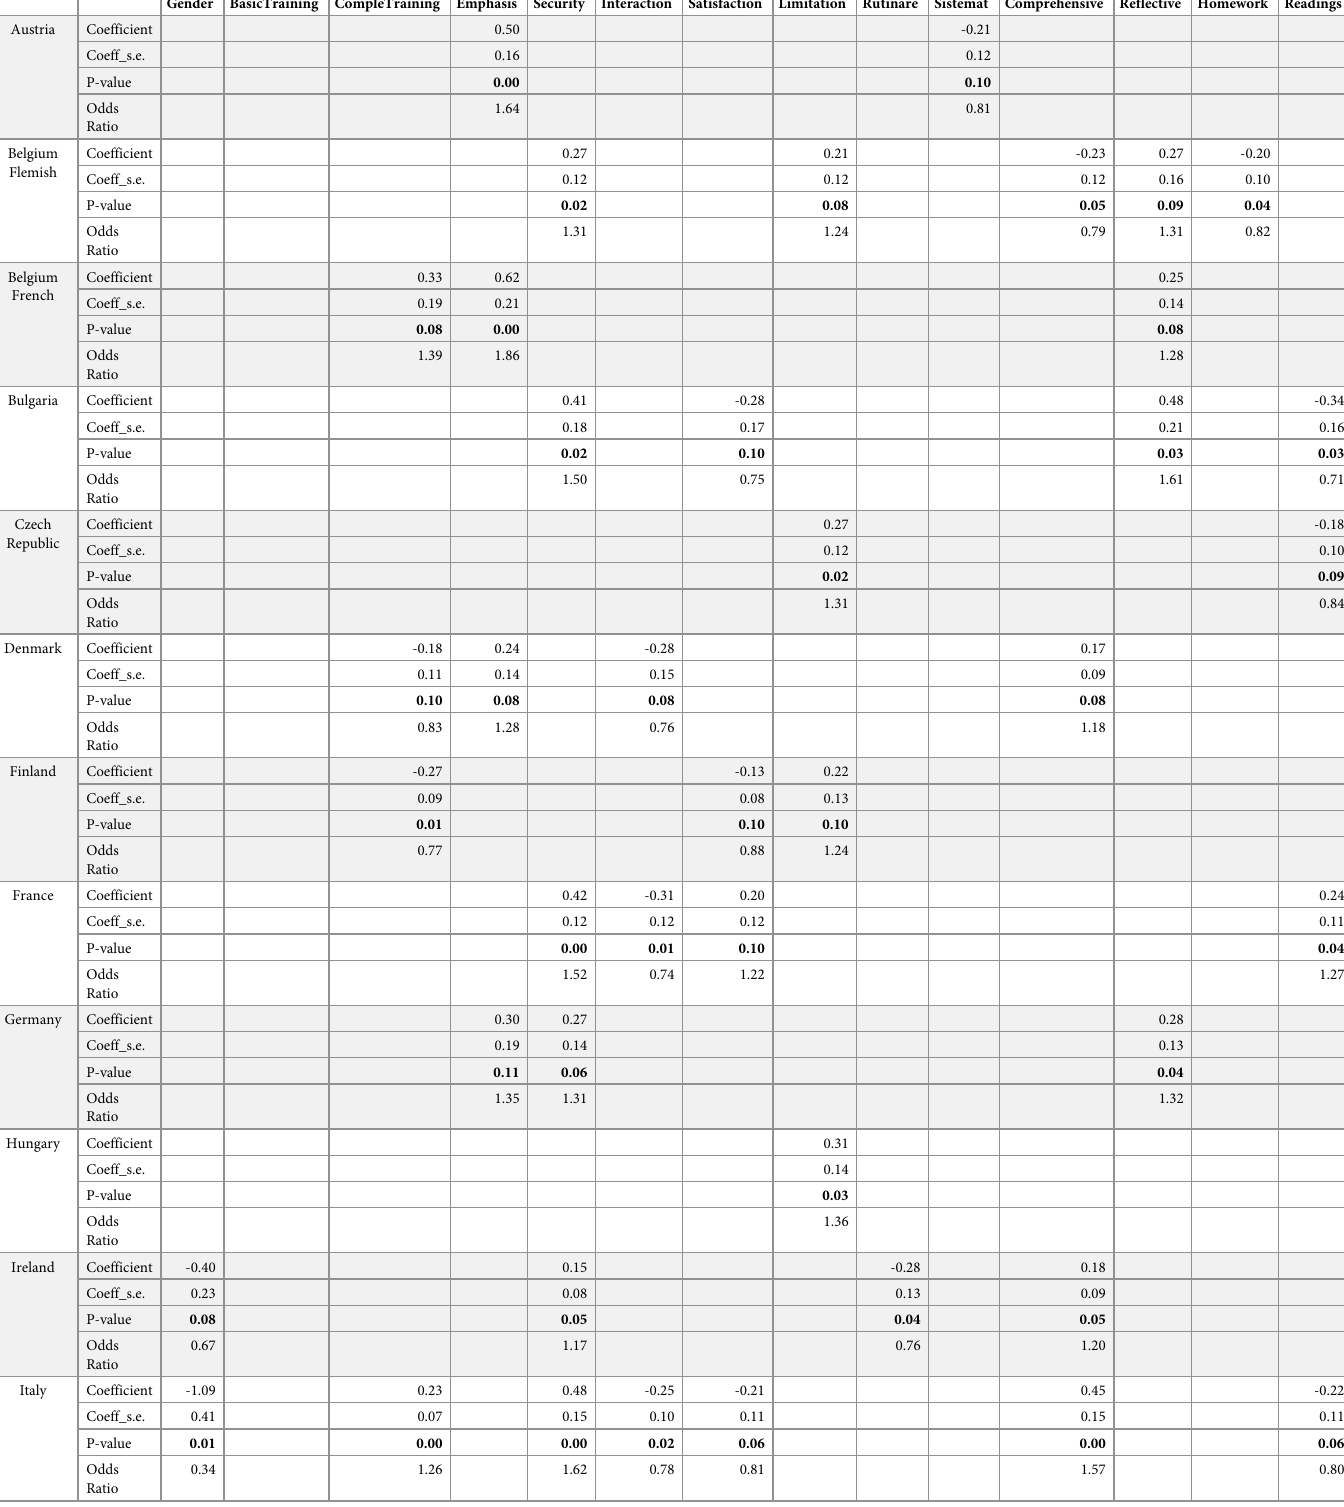
Table 6. Coefficient, p-value, and odds ratio of variables related to